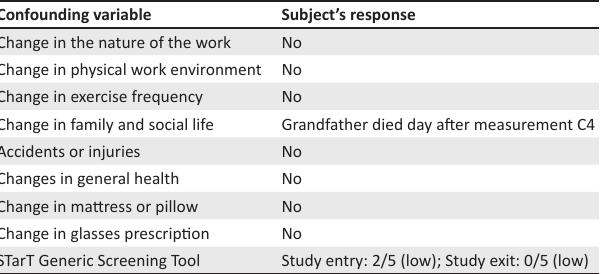
TABLE 6: Assessment of known confounders (end of phase C and relating to the previous 3 months).